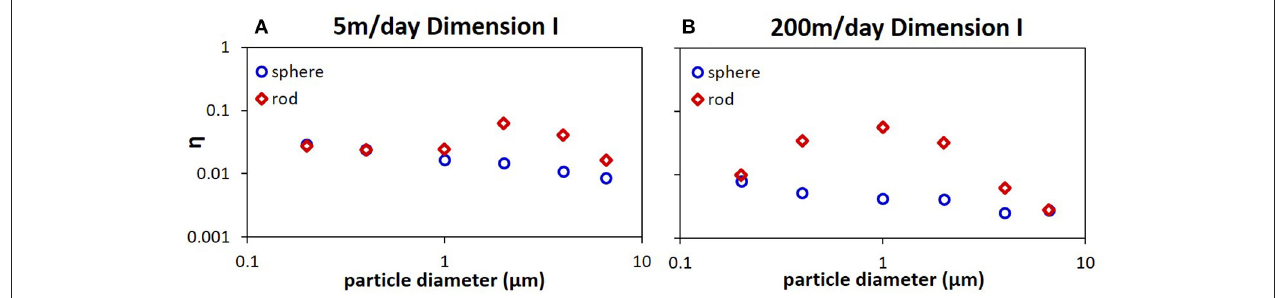
FIGURE 5 | Simulated collector efficiencies as a function of particle size for polystyrene spheres (blue circles) and rods (dark red diamonds) from parallel plate model of Dimension I, under pore water velocity of 5 (A) and 200 m/day (B) . Flow direction was aligned to the direction of gravity. The statistical error was about 5–10%. Other simulation conditions were given in Table 1 .